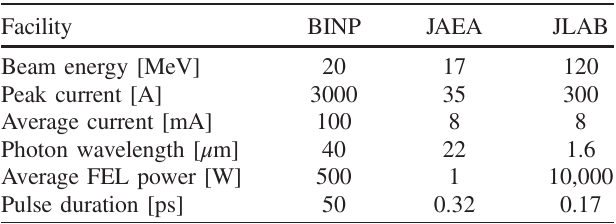
TABLE I. Parameters of some operating ERL-based FELs.